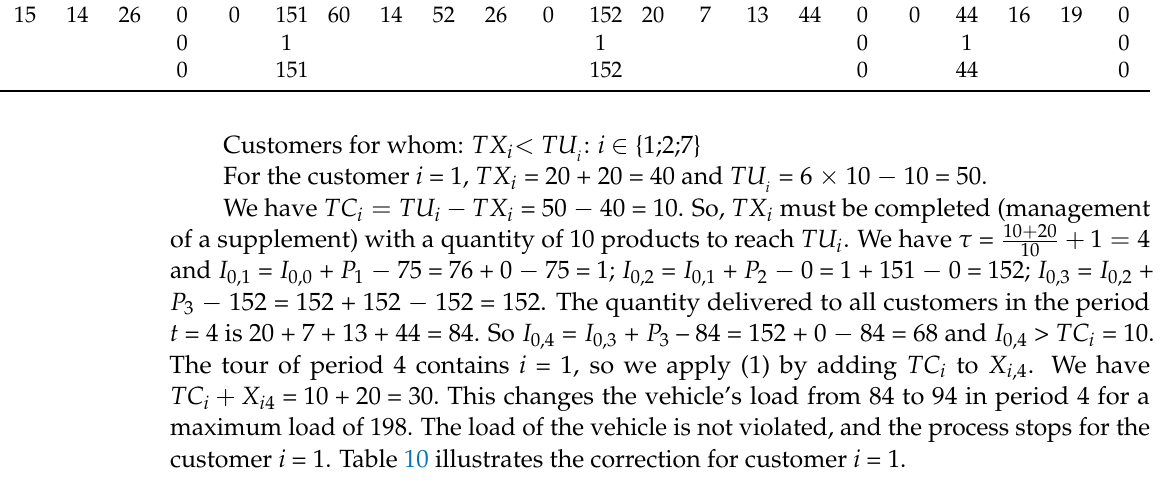
Table 10. Correction for i = 1 in C .